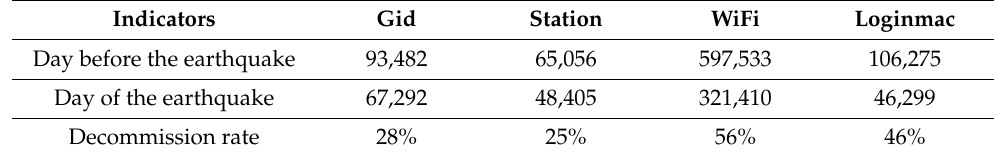
Table 1. Total number and decommission rates of mobile